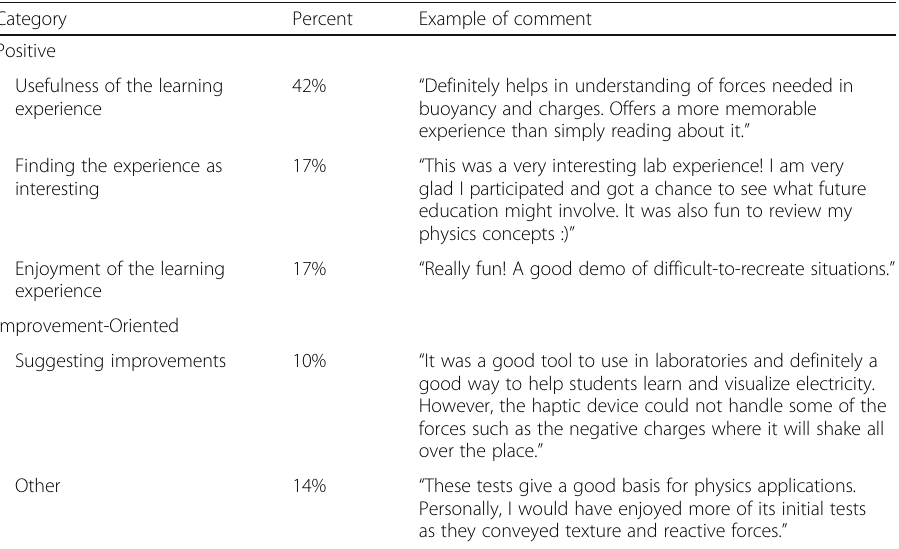
Table 6 Categories and percentage of responses about learning perceptions Category Percent Example of